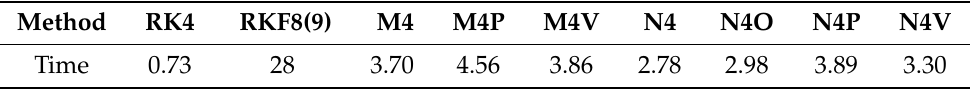
Table 5. CPU times (unit: second) of each algorithm in Figure